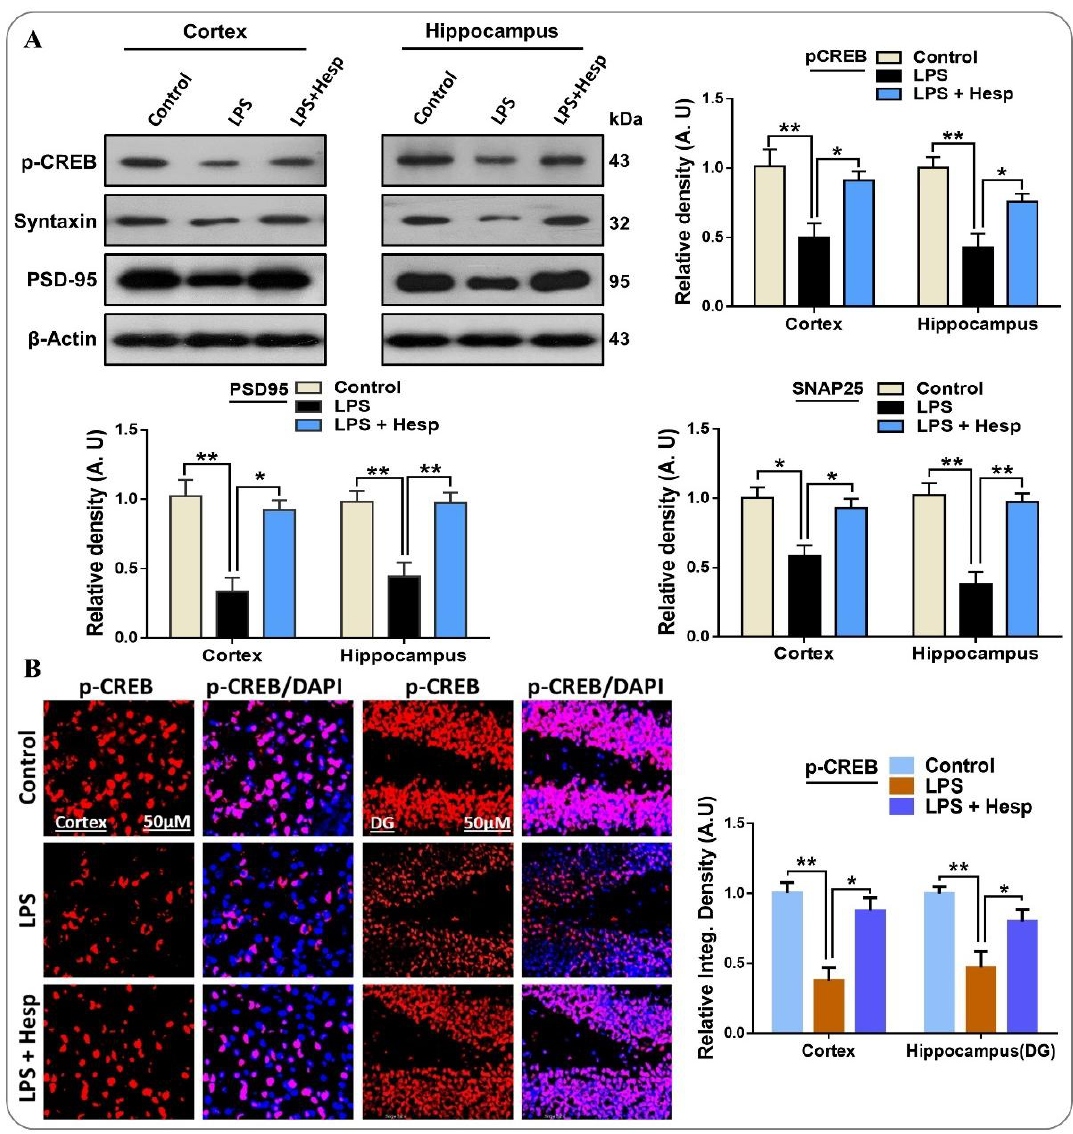
Figure 8. Hesperetin attenuated the detrimental effects of LPS on the synaptic and memory-related proteins in the mouse brain: ( A ) Western blot analysis representing the expression level of p-CREB, Syntaxin, and PSD-95 in the cortex and hippocampus of the experimental groups; ( B ) confocal immunofluorescent photomicrographs of p-CREB reactivity in the cortex and DG region of hippocampus of the experimental groups. The data are presented as the mean ± SEM of 7–10 mice per group and are representative of three independent experiments, * p ≤ 0.05, ** p ≤ 0.01.